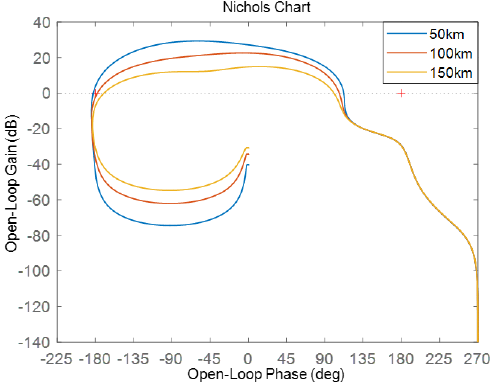
Figure 11. Nichols plots of T m under different DC cable lengths.